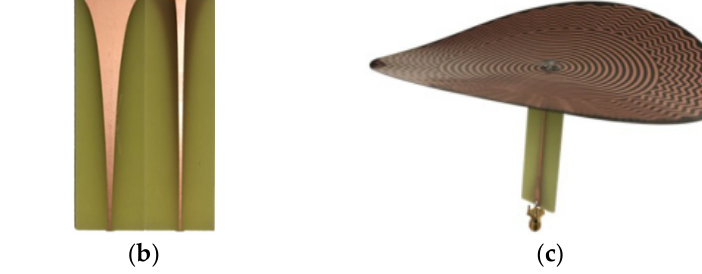
Figure 20. The flexible Archimedes spiral antenna studied in [127]: ( a ) the antenna body on a flexible thermosetting polyimide (TPI) substrate, ( b ) the antenna feedline, which is an exponential gradient microstrip balun, and ( c ) the total assembled structure.